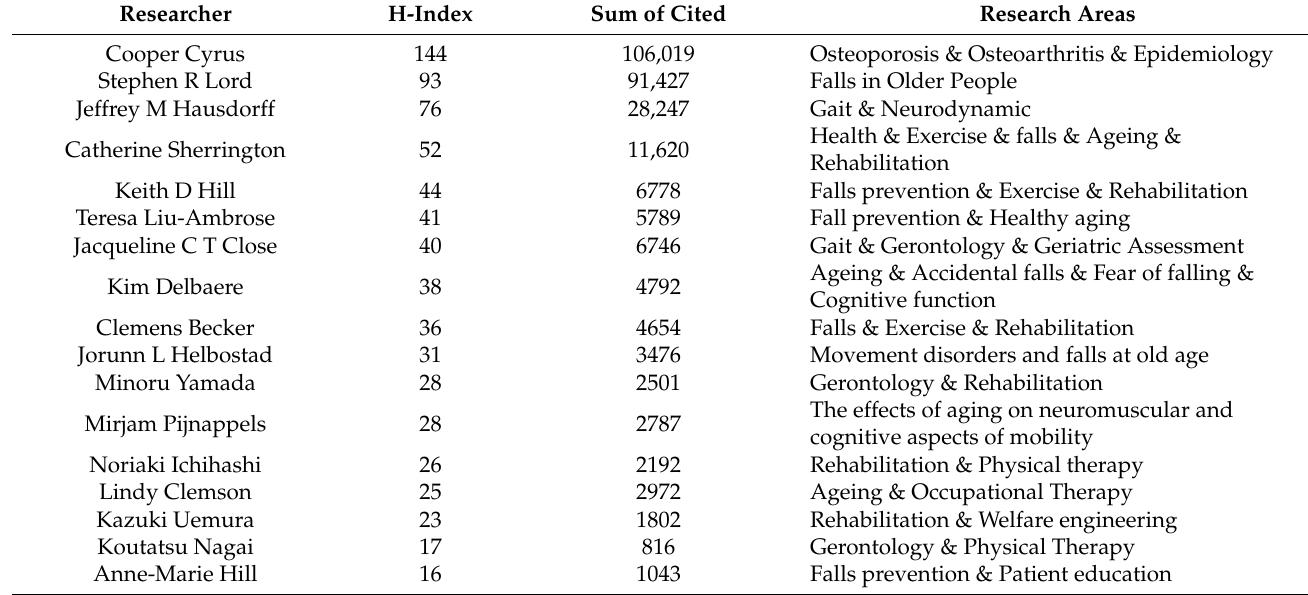
Table 3. Researchers’ academic